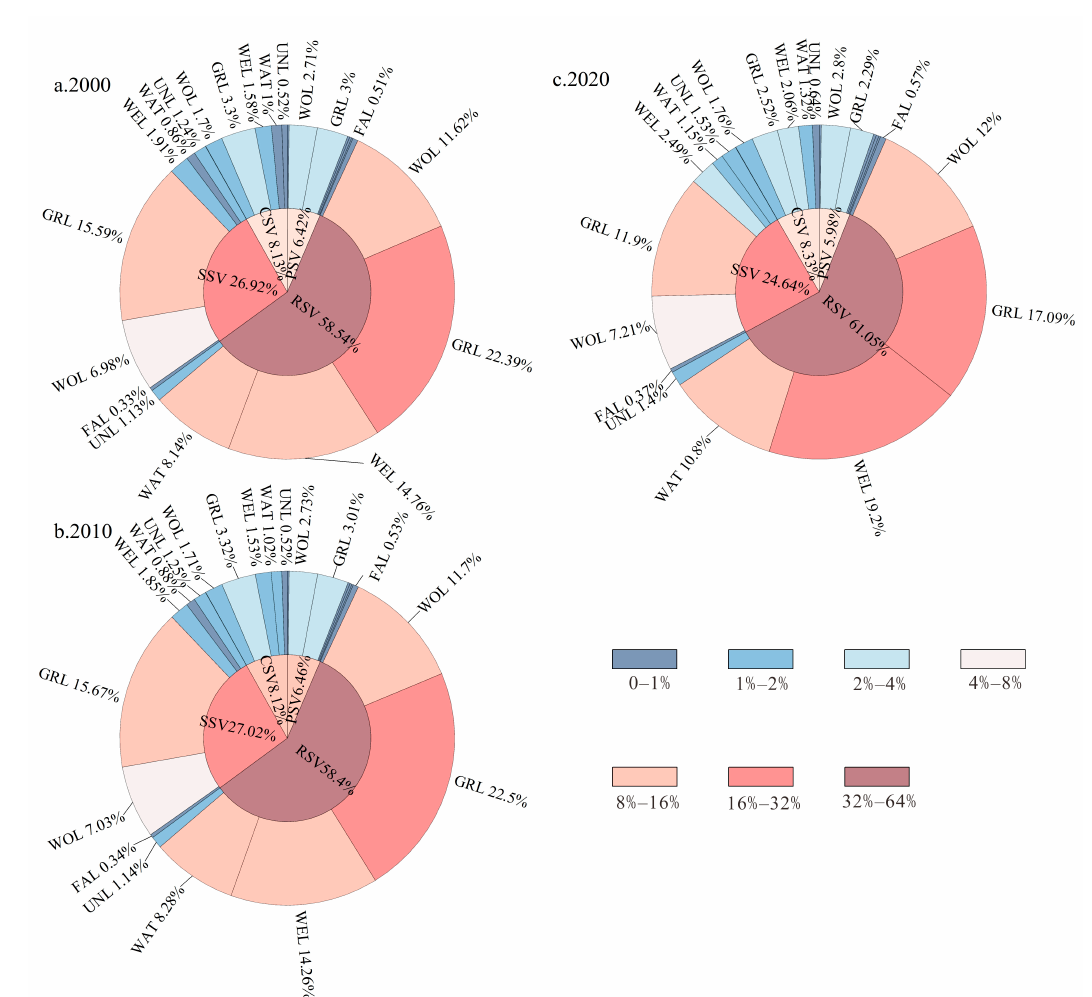
land, UNL: unused land.